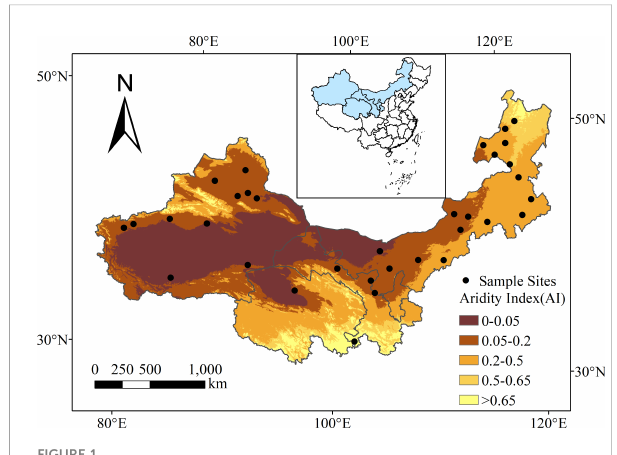
FIGURE 1 Distribution of the 33 sampling sites in drylands of northern China. The background map is aridity index (AI; generated by ArcGIS 10.3). Inset map shows China with the study area in